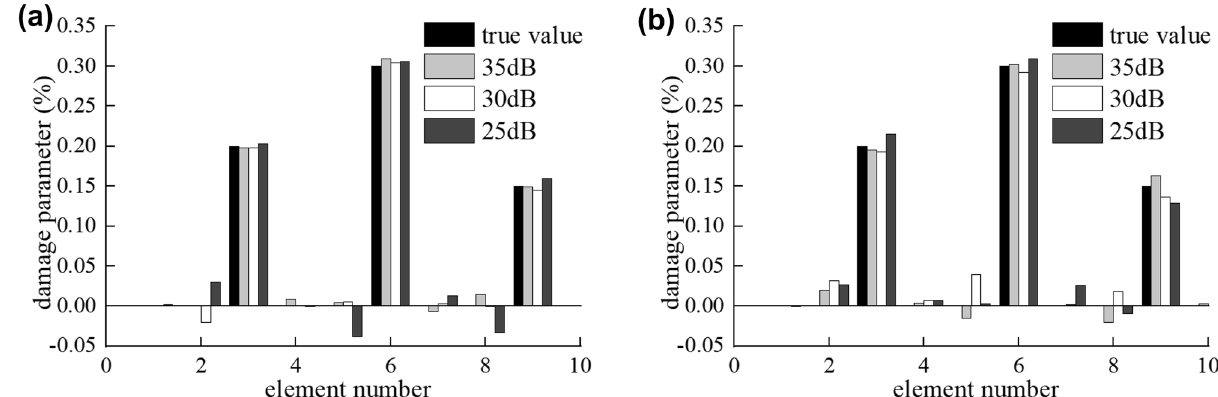
Figure 13. Identification results of moving force and structure damage on Class A road surface ( a ) with the speed of 10 m/s and ( b ) with the speed of 20 m/s.